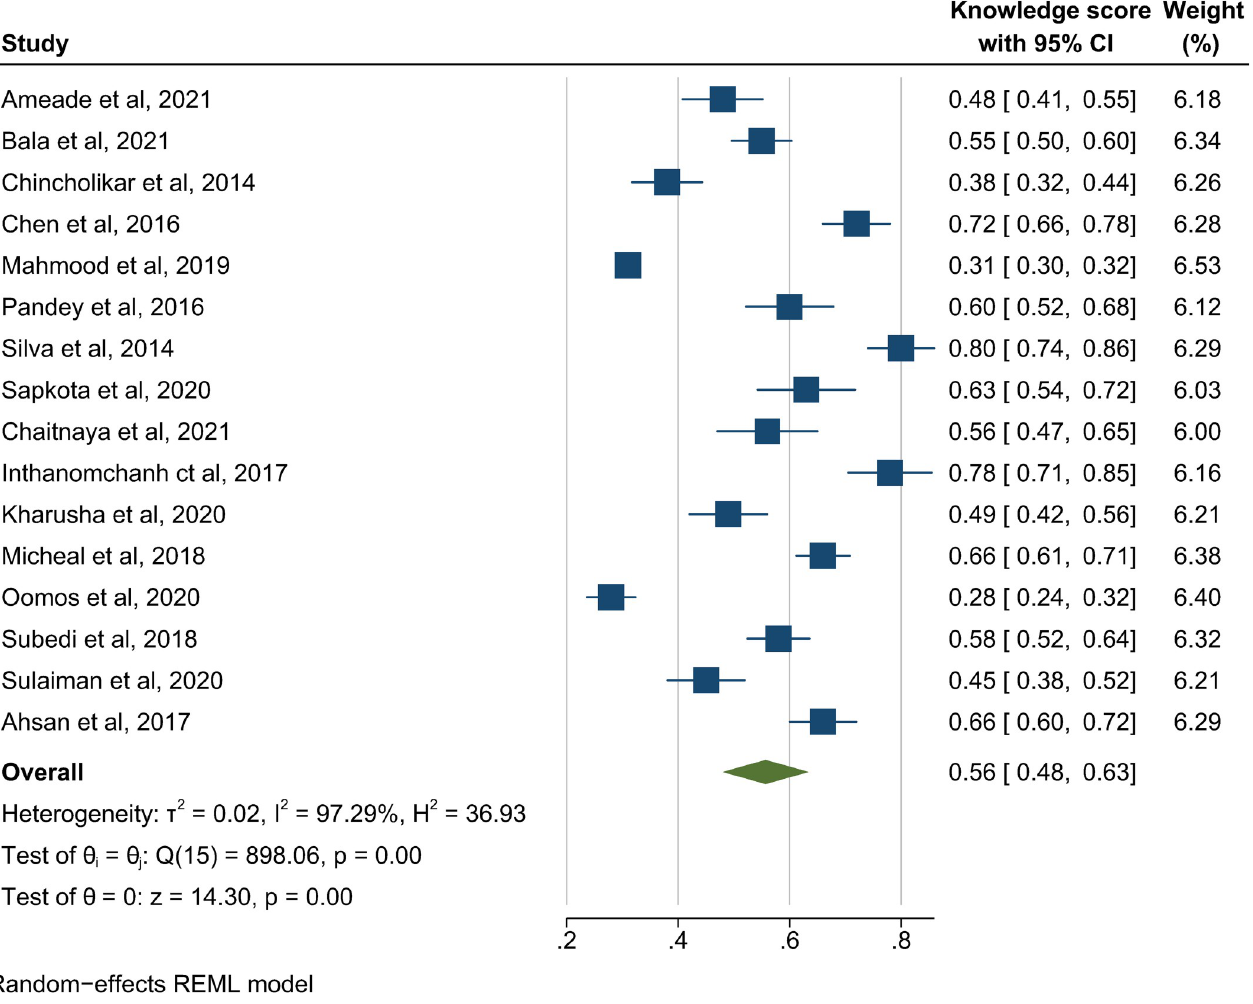
Fig 3. Pooled proportion of knowledge about snakebite, REML-Restricted Maximum Likelihood